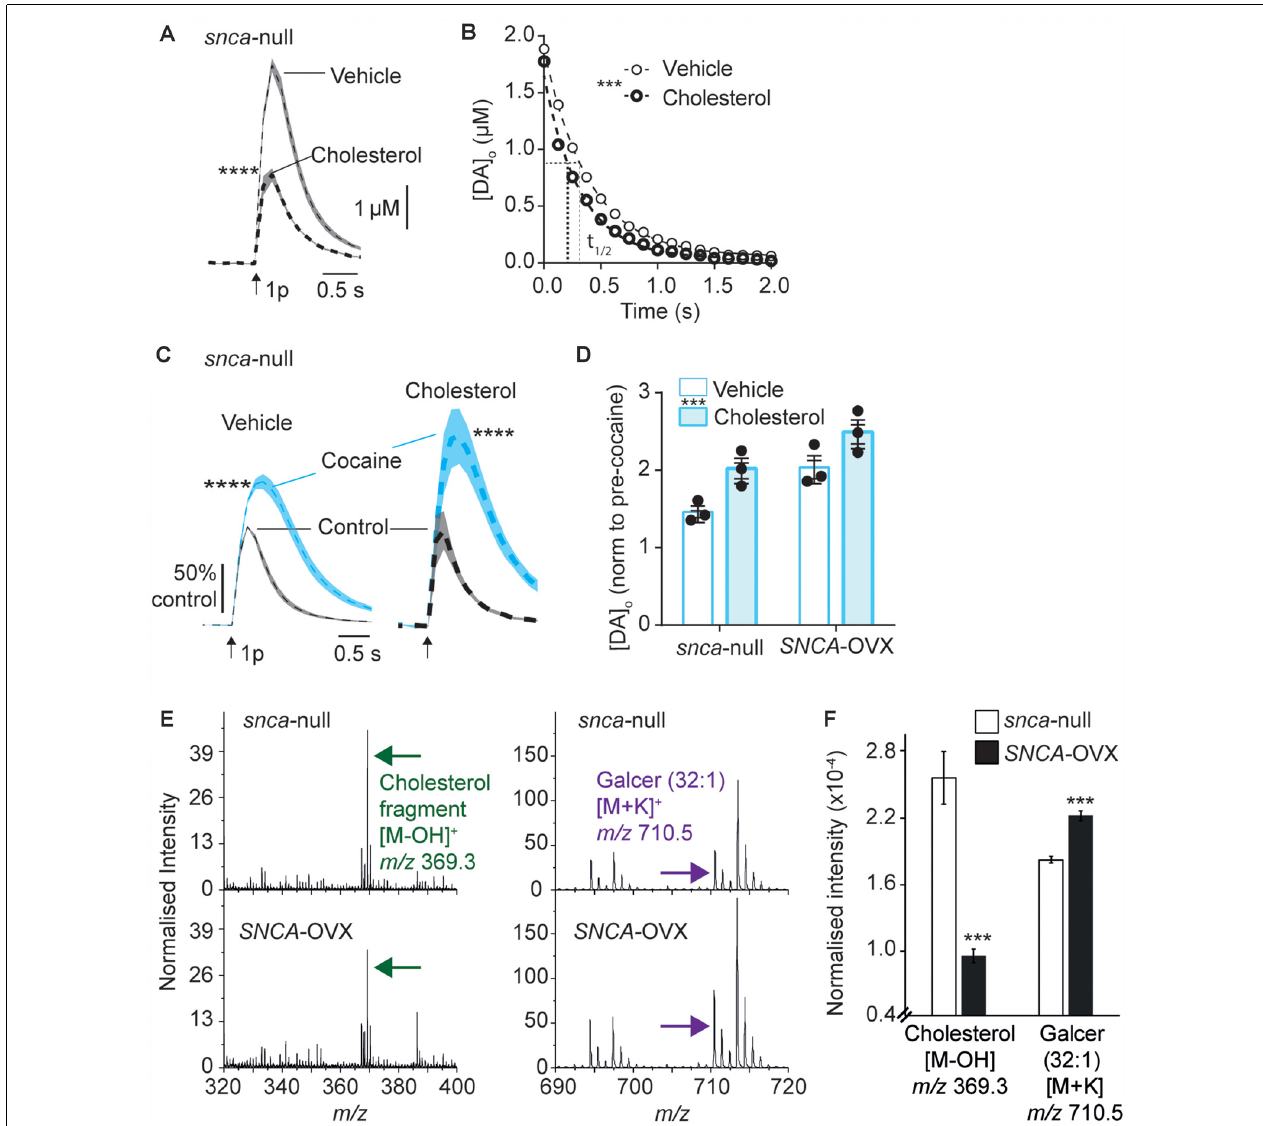
FIGURE 3 | Applied cholesterol potentiates DAT function. (A) Mean [DA] o ± SEM vs. time evoked by single pulses ( arrow ) in CPu from Snca -null mice incubated in vehicle or ws-cholesterol. **** P < 0.0001. (B) One-phase exponential decay curve fits for falling phases of mean [DA] o transients concentration-matched. k (s − 1 ) 2.54 (vehicle) vs. 3.14 (cholesterol), half-lives ( t (1/2) ) are indicated by for vehicle (fine line) and cholesterol (thick dotted), F (1,617) = 46.4, *** P < 0.0001. (C) Mean [DA] o (normalized to control conditions) ± SEM vs. time evoked by single pulses ( arrow ) in CPu of Snca -null mice, in control ( black ) and in the presence of cocaine ( blue ) from slices incubated in vehicle or cholesterol. **** P < 0.0001. (D) Summary of effects of cocaine on mean peak [DA] o ± SEM, normalized to pre-cocaine condition. Two-way ANOVA: effect of cholesterol, F (1,8) = 14.9, *** P = 0.005; effect of genotype, F (1,8) = 15.8, P = 0.004; Genotype x cocaine interaction, F (1,8) = 0.15, P = 0.70. (E) Secondary ion mass spectrometry (SIMS) analyses of Snca -null (top) and SNCA -OVX (bottom) striatum groups obtained from the striatum region of brain tissue in positive ion mode. Cholesterol (green arrow) and galactosylceramide ( galcer ; purple arrow) signal intensity (normalized to the number of selected pixels for the spectrum). (F) Statistical comparison of striatal lipid species cholesterol and galcer (32:1). In SNCA − / − (unfilled bars) and SCNA -OVX (filled bars) Mean ± SEM (normalized to the total ion count). 2-sample T -test, n = 12, ∗∗∗ P <